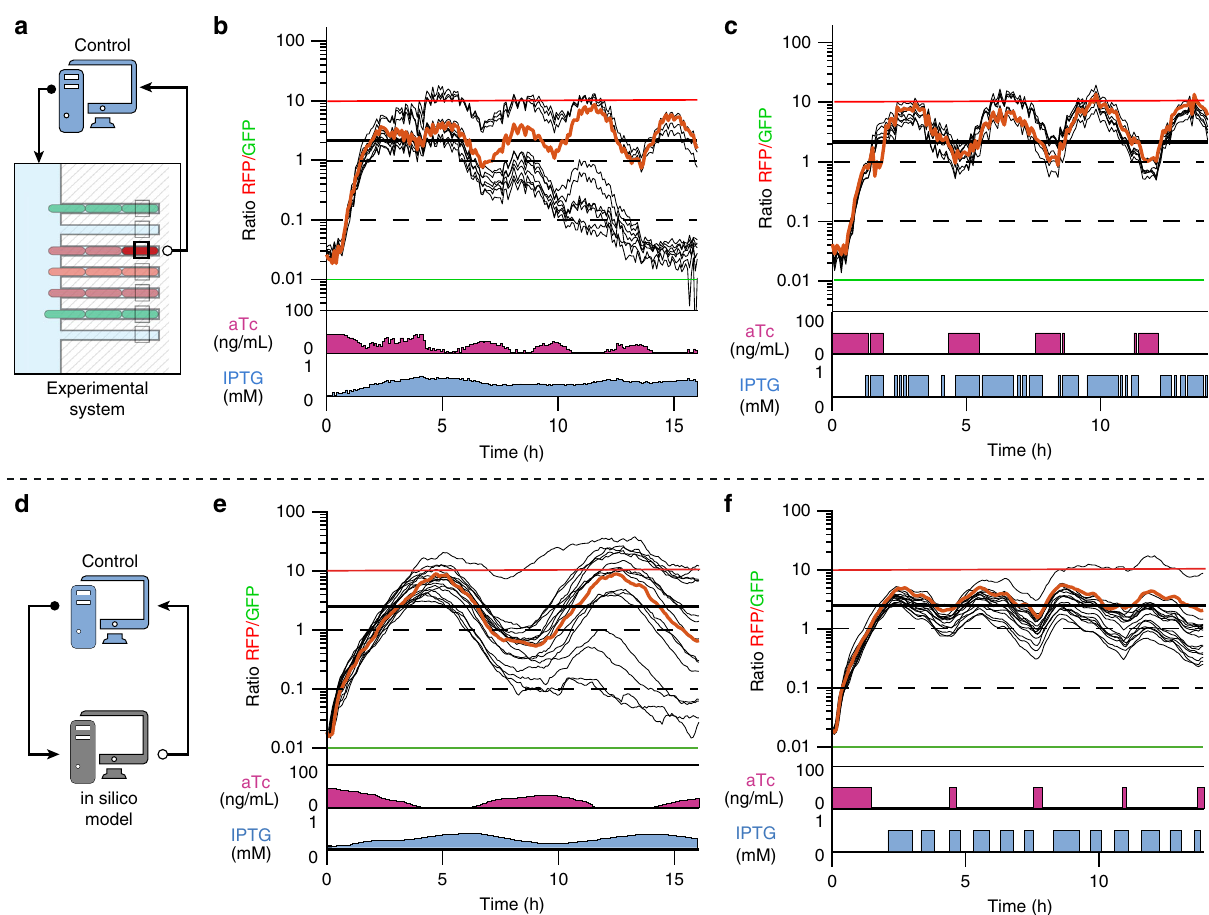
Fig. 3 Additional control experiments show that single cells can be controlled with PI and Bang-Bang controllers. a Experimental control principle. The controller uses the fl uorescence measurements for a single cell (the controlled cell) to compute control inputs (aTc and IPTG levels). Yet, all cells in the fi eld of view were imaged during the process. b Ratio of RFP (LacI) and GFP (TetR) levels for the controlled (orange) and in the fi eld of view (black, n = 11) cells for the control experiment shown in Fig. 2c. Some cells escaped to a GFP-dominant state, while others remained close to the control target. c Using a bang-bang control strategy (on/off control) led to an equally good result for the controlled cell. Surprisingly, in this case, all cells ( n = 8) faithfully followed the controlled cell. d In silico control principle. e , f . Similar results to those in b , c were observed in the in silico control experiments. Trajectories ( n = 16) were obtained by simulating the behavior of cells placed in the same dynamic environment than that of the controlled